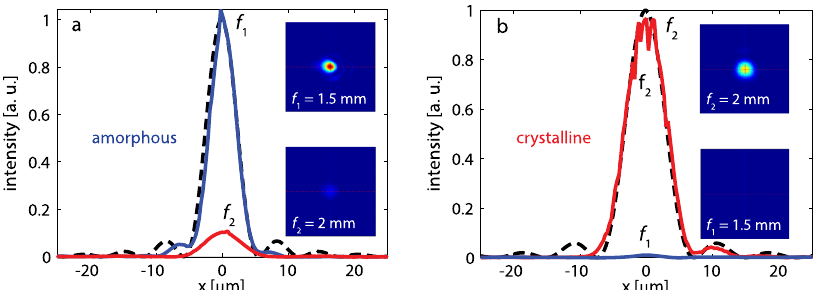
Fig. 4 Optical characterization. Focal spot pro fi les for the metalens in two states: a amorphous and b crystalline. Each plot contains the focal spot intensity distributions for the f 1 = 1.5 mm and f 2 = 2 mm focal planes. All the focal spots are diffraction-limited. The focal spots produced by ideal, aberration-free lenses of the same numerical aperture are marked with black dashed-curves. The insets show the 2-D images of the focal spots: f 1 = 1.5 mm and f 2 = 2 mm. Power contrast ratios are 10:1 and 90:1 for the a- and